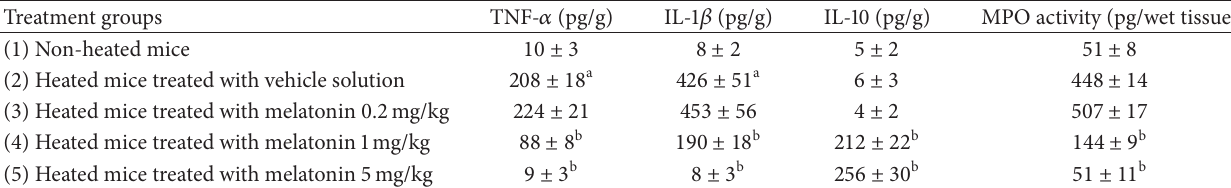
Table 3: Effects of heat exposure on hypothalamic levels of various parameters in different groups of mice. Treatment groups